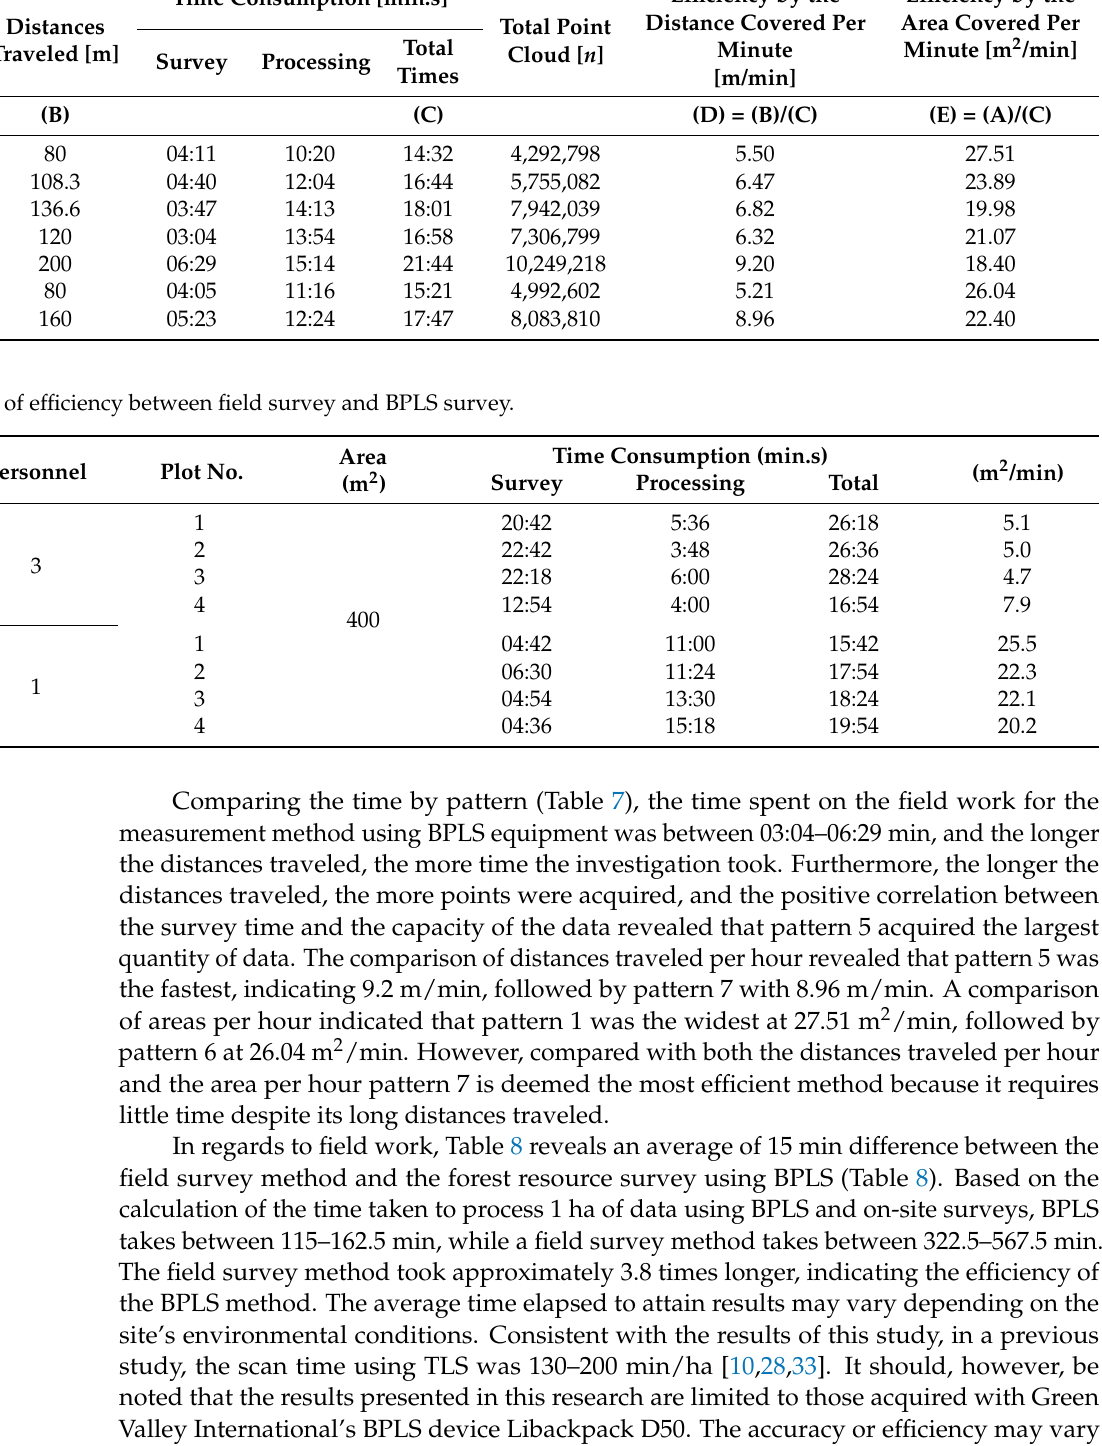
Table 7. The amount of the time elapsed on patterns and the number of point clouds acquired.